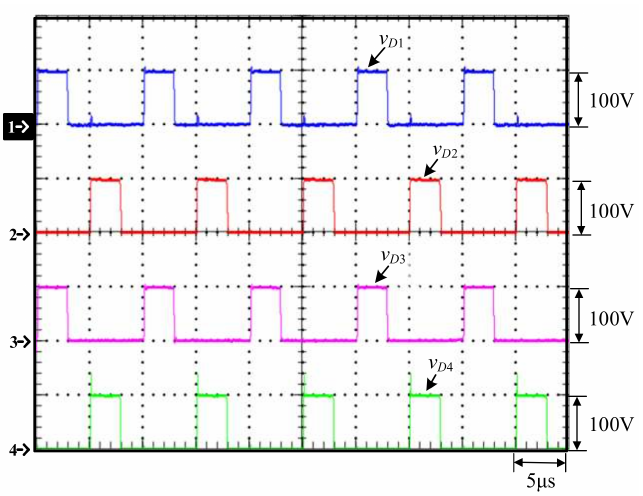
Figure 20. Measured waveforms relevant to rated load: (1) v D 1 ; (2) v D 2 ; (3) v D 3 ; (4) v D 4 .